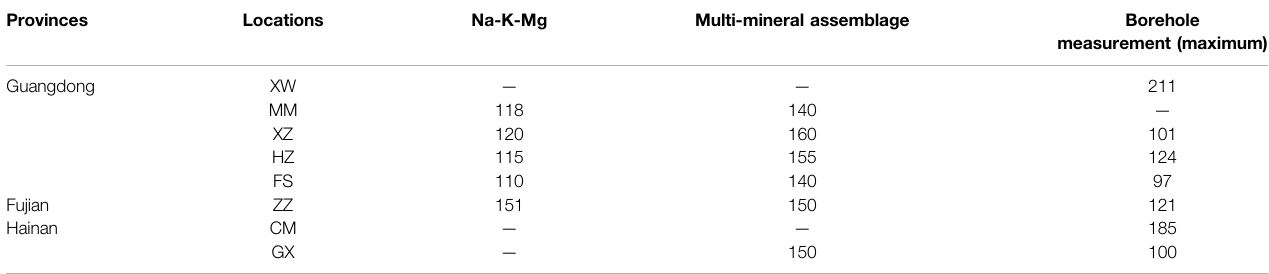
TABLE 5 | Reservoir temperature prediction from various methods.